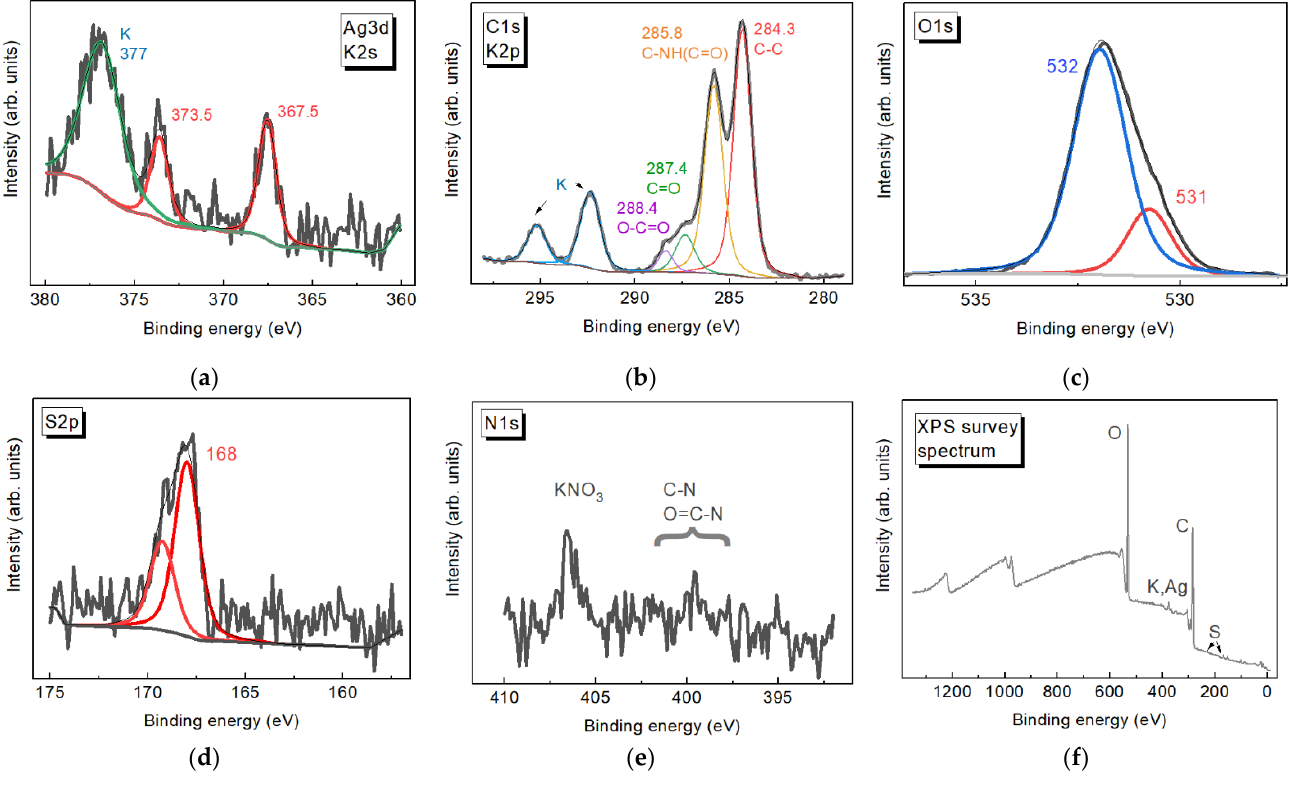
Figure 3. High-resolution XPS spectra of the Ag NPs synthesized with Common toothwort extract: Ag/K ( a ), C/K ( b ), O ( c ), S ( d ), N ( e ). A survey spectrum in the range of all elements is shown in ( f ).